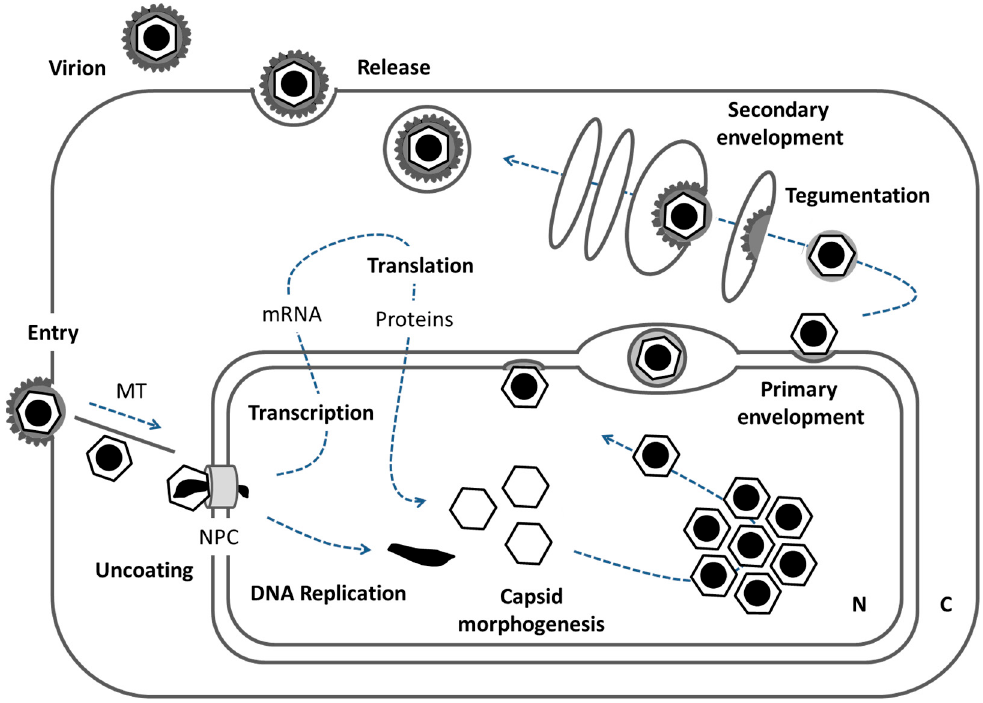
Figure 1. The herpesviral replication cycle. Schematic representation of a host cell and the processes that allow for herpesviral replication. For details see introduction (N: nucleus, C: cytoplasm, MT: microtubules, NPC: nuclear pore complex).